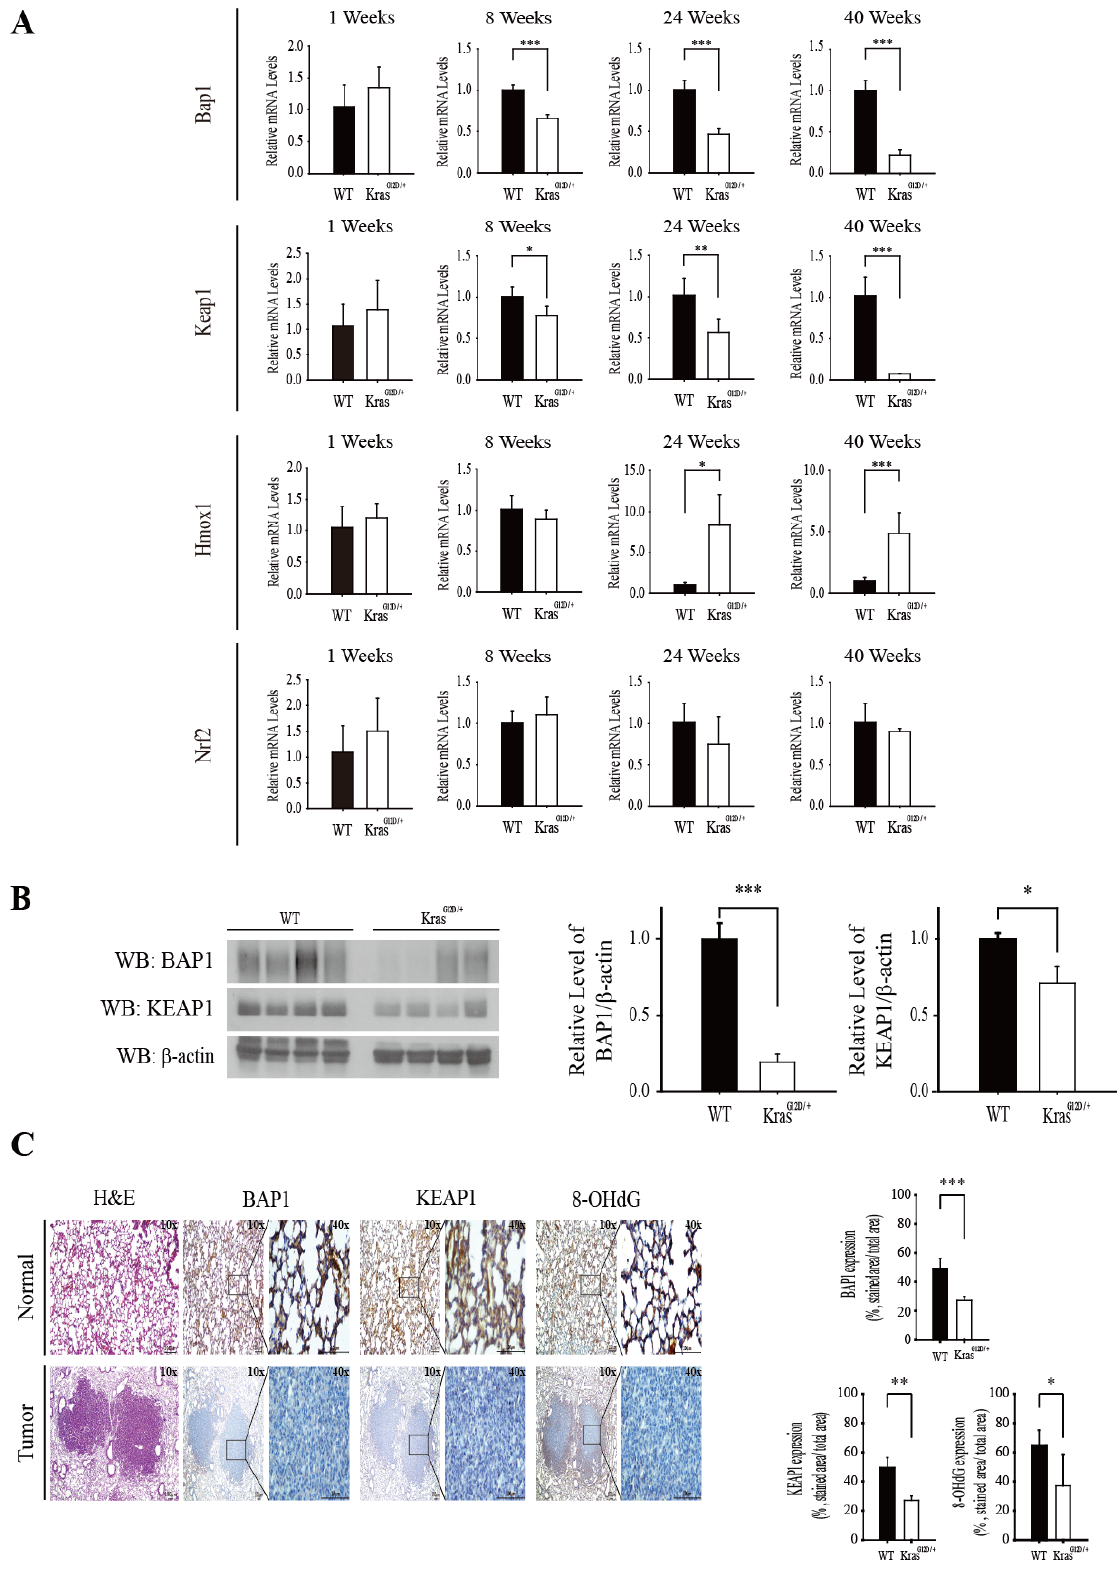
Figure 4. KEAP1 and BAP1 progressively decrease during lung tumor formation in Kras G12D/+ mice, contributing to NRF2 activation and the inhibition of oxidative stress. ( A ) The level of Bap1 and Keap1 mRNAs progressively decreases and that of Hmox1, a target gene of NRF2, progressively increases during lung tumor formation in Kras G12D/+ mouse. Wild-type mice ( n = 16) and Kras G12D/+ mice ( n = 16) were sacrificed after 1 week ( n = 4 per group), 8 weeks ( n = 4 per group), 24 weeks ( n =